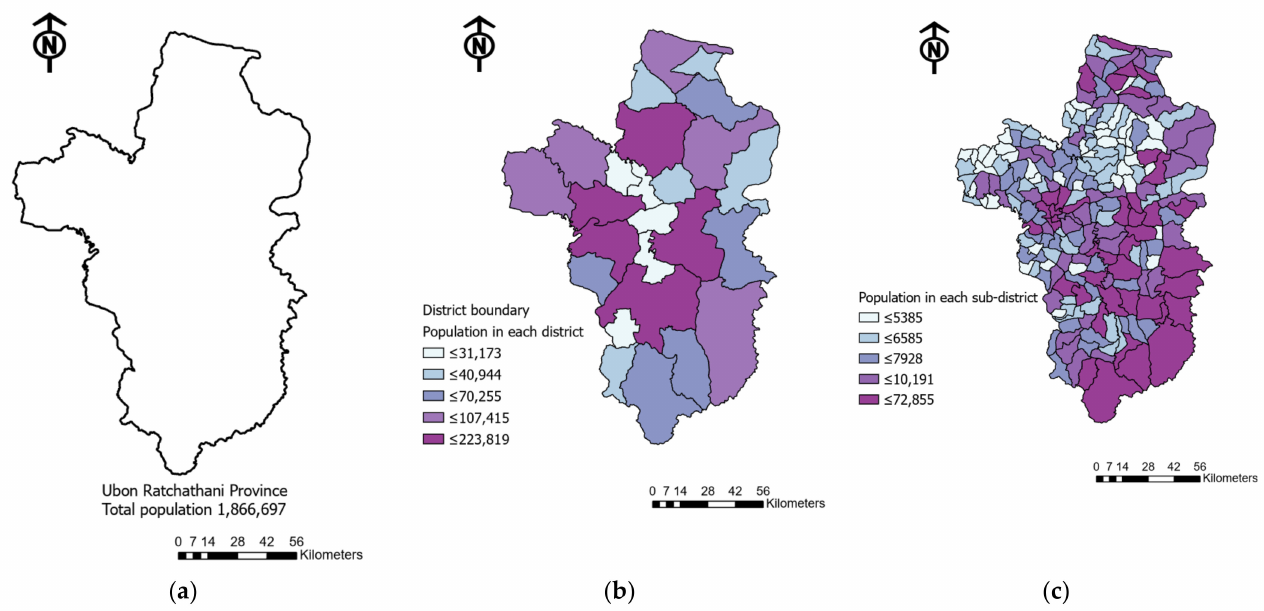
Figure 2. Area-based mapping of the research study: ( a ) original administrative unit scale of the province polygon; ( b ) polygons divided into smaller areas at the district level; ( c ) finer scale of sub-district-level